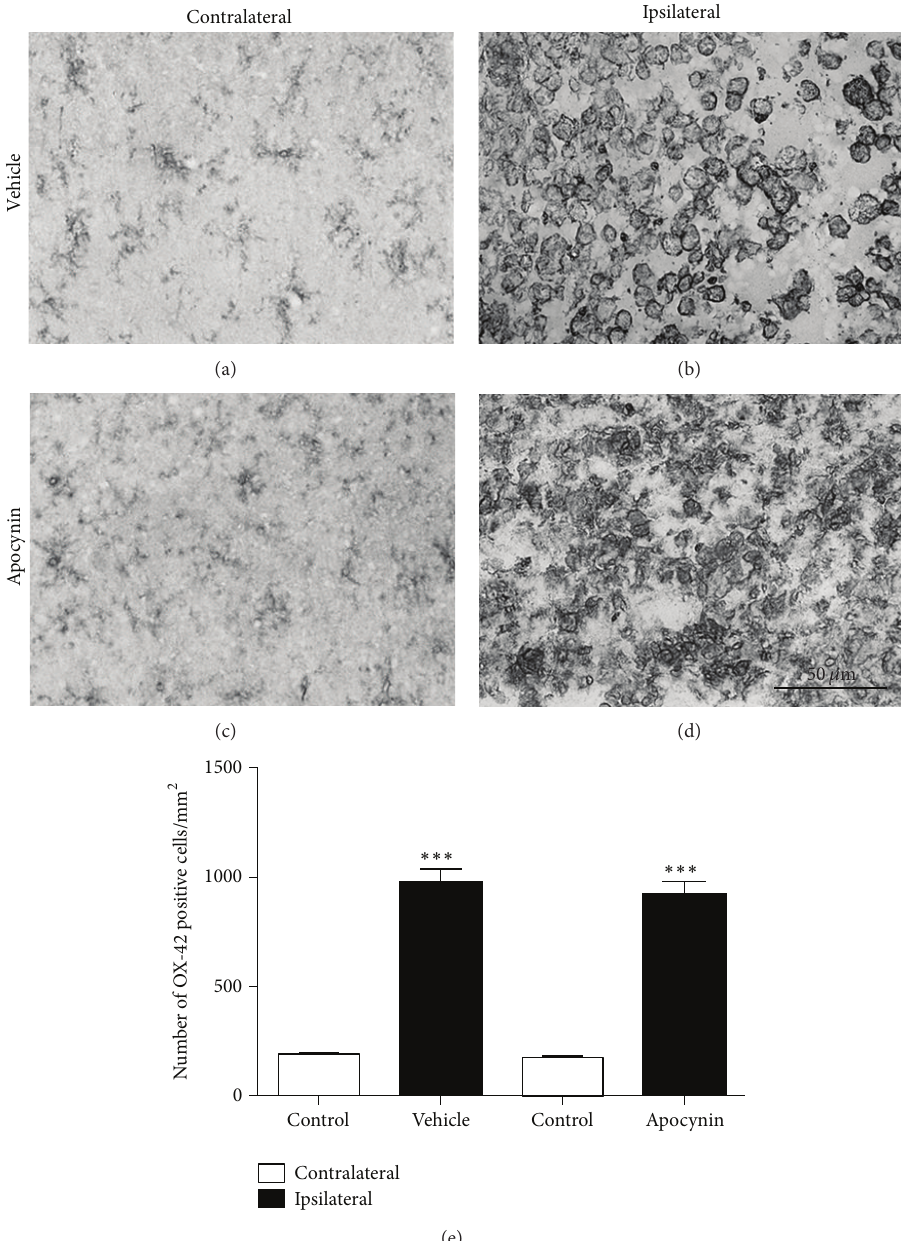
F 7: Immunohistochemical localization of activated microglia/macrophages by OX-42 in the stroke-affected cortex ((b), (d)) and the contralateral mirror image ((a), (c)), in vehicle control ((a), (b)) and apocynin- ((c), (d)) treated rats. Cell counts of micrographs taken from the stroke-affected cortex show no effect on the number of OX42 positive cells between vehicle control and apocynin treatment (e). 0.001 versus contralateral control. Scale bar = 50 𝜇𝜇